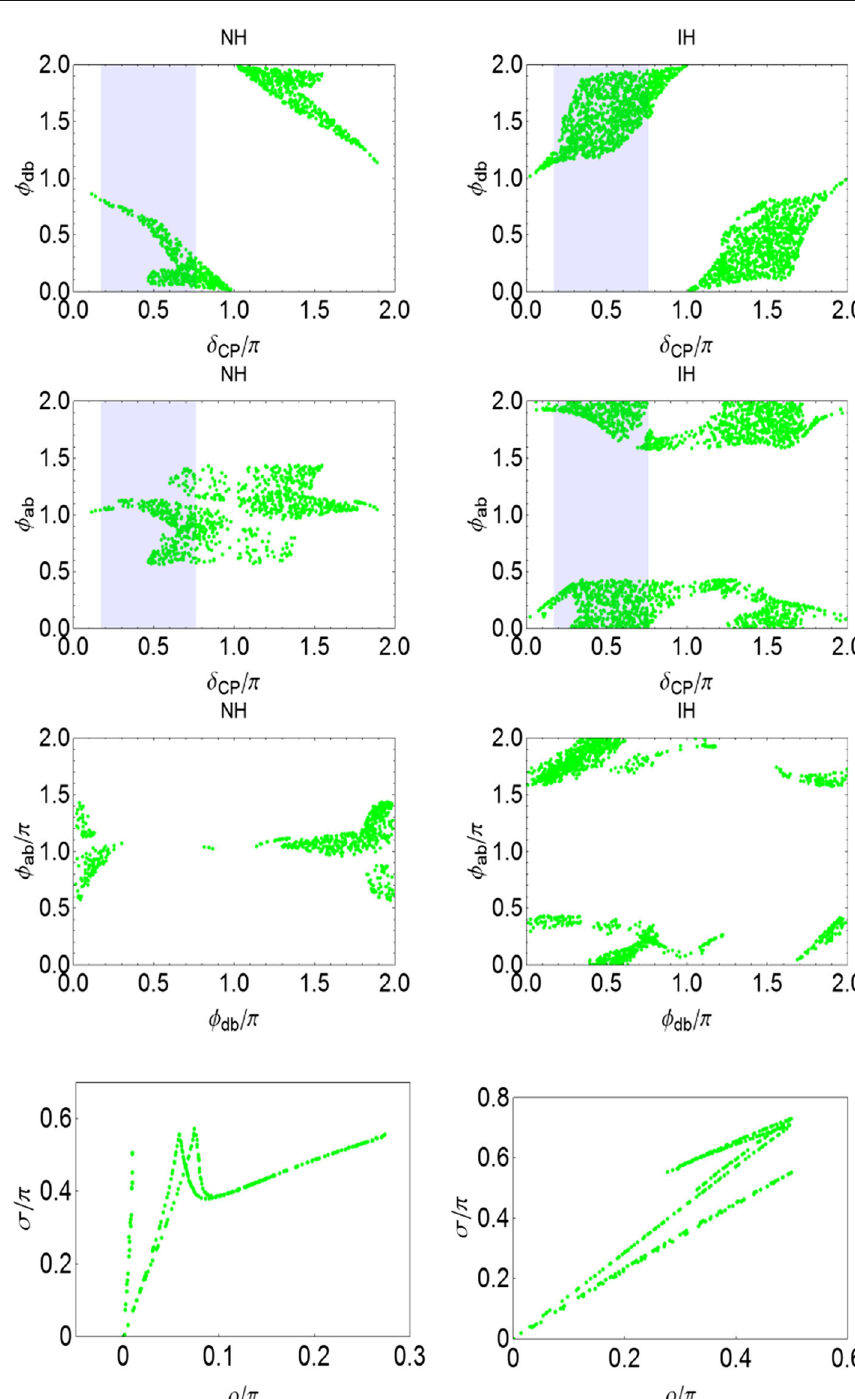
Fig. 4 Correlation plots between φ db , φ ab and δ CP for normal (left panel) and inverted (right panel) hierarchy. The vertical band represents the values of δ CP beyond its 3 σ